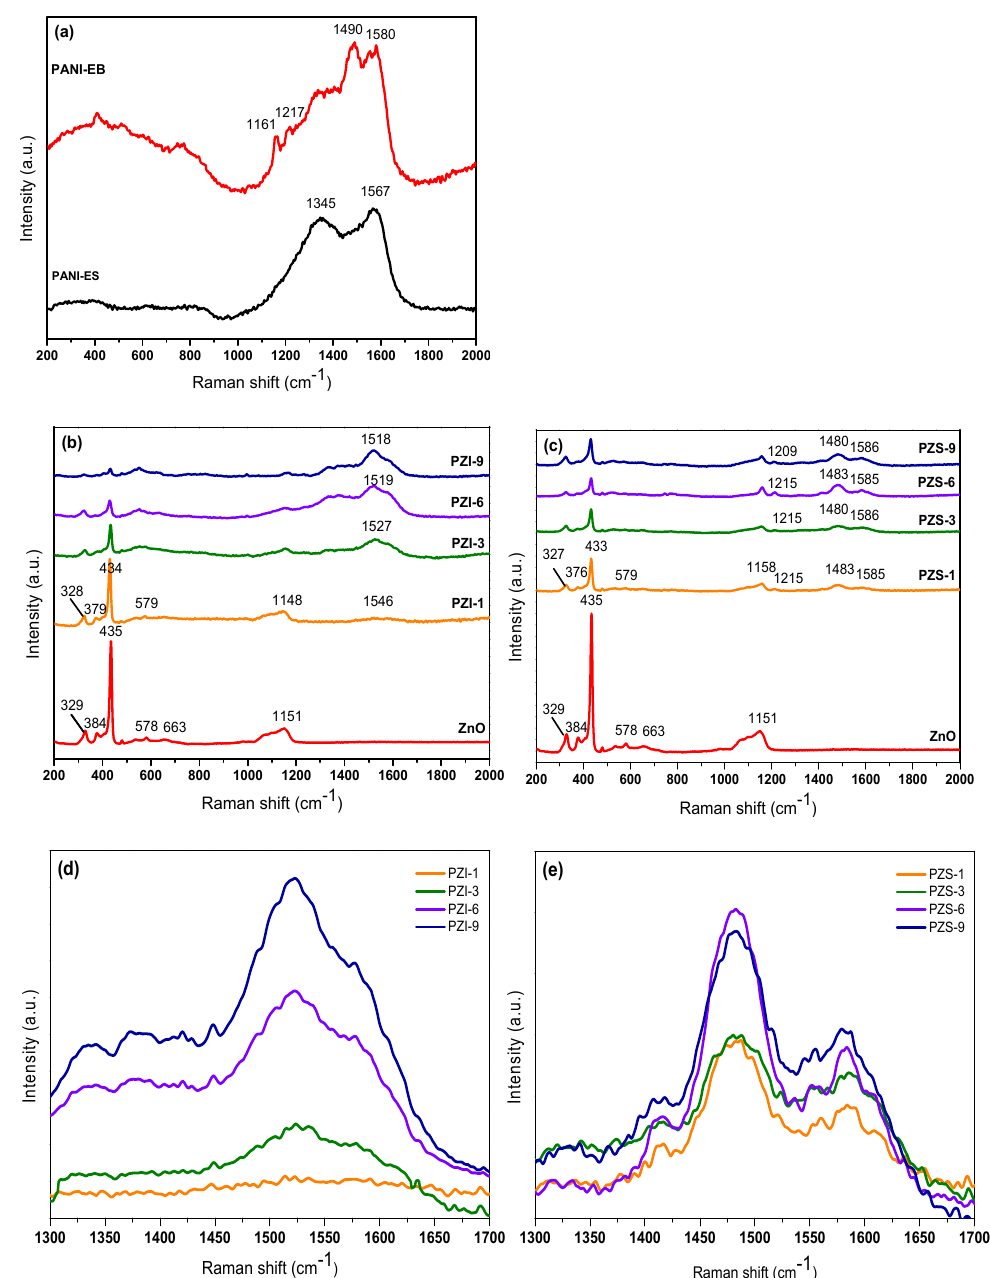
Figure 3. Raman spectra of ( a ) PANI-ES and PANI-EB, ( b ) ZnO and PZI composites, ( c ) ZnO and PZS composites, ( d ) regional enlarged spectra of PZI composites and ( e ) regional enlarged spectra of PZS composites.